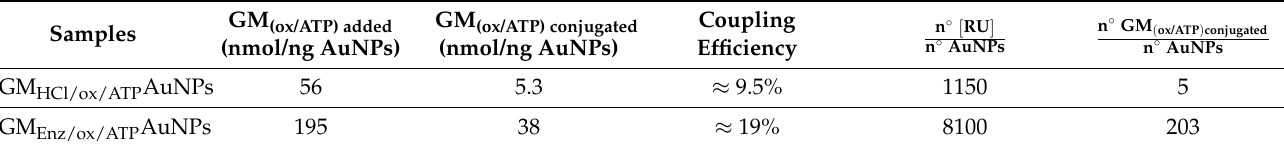
Table 3. Amounts in nmol of thiolated polysaccharide (GM ox/ATP ) per ng of AuNPs added and of AuNPs conjugated. Cou- pling efficiency (%) of thiolated polysaccharides expressed as the ratio between GM (ox/ATP)conjugated and GM (ox/ATP)added . Number of repeat units [RU] per AuNPs. Number of conjugated polymer chains (GM (ox/ATP)conjugated ) per AuNP.